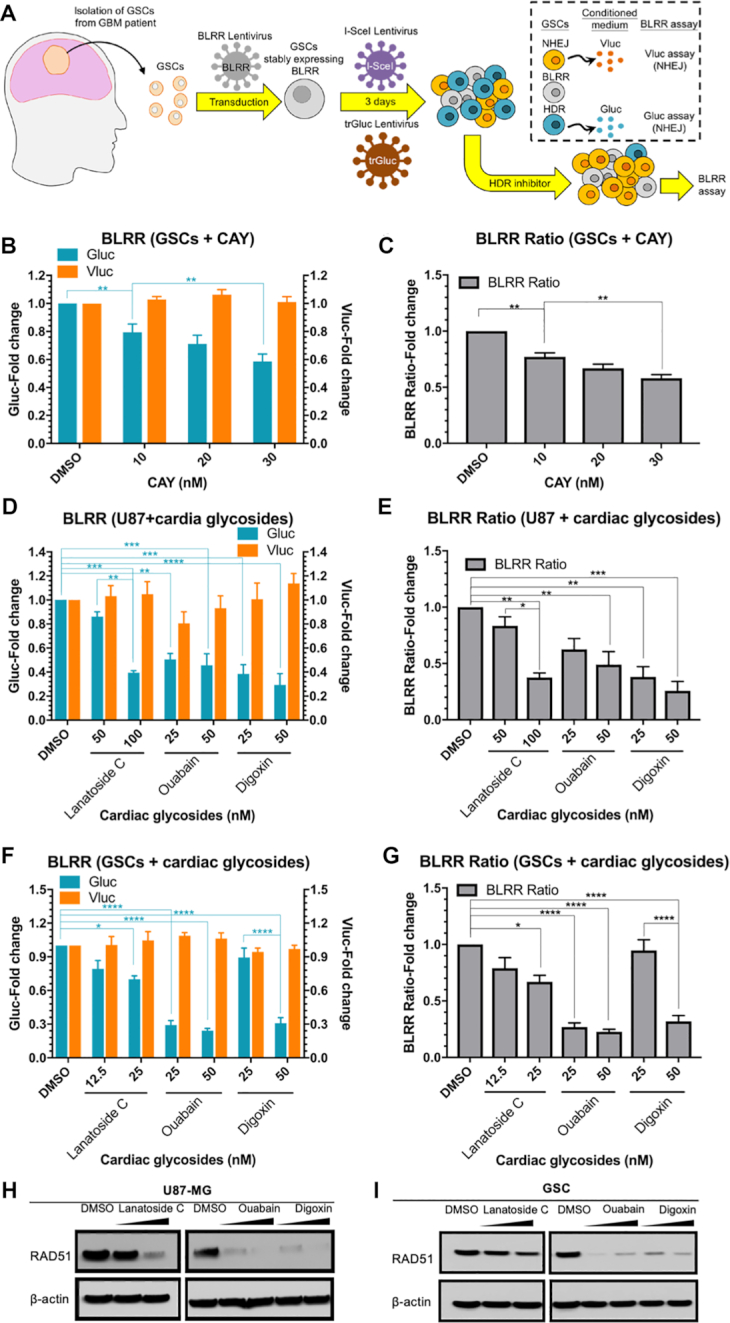
The BLRR assay reveals HDR-suppressing effects of cardiac glycosides in GSC and GBM cells. (A) Schematic diagram of the BLRR assay in patient-derived GSCs. GSCs from patients were stably transfected with BLRR, then sequentially transfected with lentiviruses encoding trGluc and I-SceI, followed by treatment with small-molecule candidate HDR inhibitors to assess DSB repair by BLRR assay. (B) The BLRR assay reveals dose-independent HDR inhibition by HDR inhibitor CAY since the Gluc signal decreases as the amount of CAY is increased, while the Vluc signal remains stable. (C) The BLRR ratio demonstrates HDR inhibition in GSCs by CAY. (D, E) Both the BLRR signal (D) and the BLRR ratio (E) reveal dose-dependent inhibition of HDR by cardiac glycosides in U87-MG GBM cells. Lanatoside C, ouabain and digoxin were treated at the indicated concentrations. (F, G) Both the BLRR signal (F) and the BLRR ratio (G) reveal dose-dependent HDR inhibition in GSCs treated with lanatoside C, ouabain and digoxin. BLRR signals were normalised against cell viability and results are shown as the fold change relative to DMSO-treated controls (mean ± SEM of three biological replicates). The BLRR ratio is shown as the fold change relative to DMSO (mean ± SEM of three biological replicates). (H) Western blot analysis revealing cardiac glycoside-induced downregulation of RAD51 in U87-MG, as well as in GSCs (I). RAD51 protein levels in U87-MG and GSCs treated with the indicated cardiac glycosides at 250 and 1000 nM for 24 h. Significance was calculated using one-way ANOVA as indicated, followed by Tukey's post-hoc test (*P < 0.05, **P < 0.01, ***P < 0.001, ****P < 0.0001).